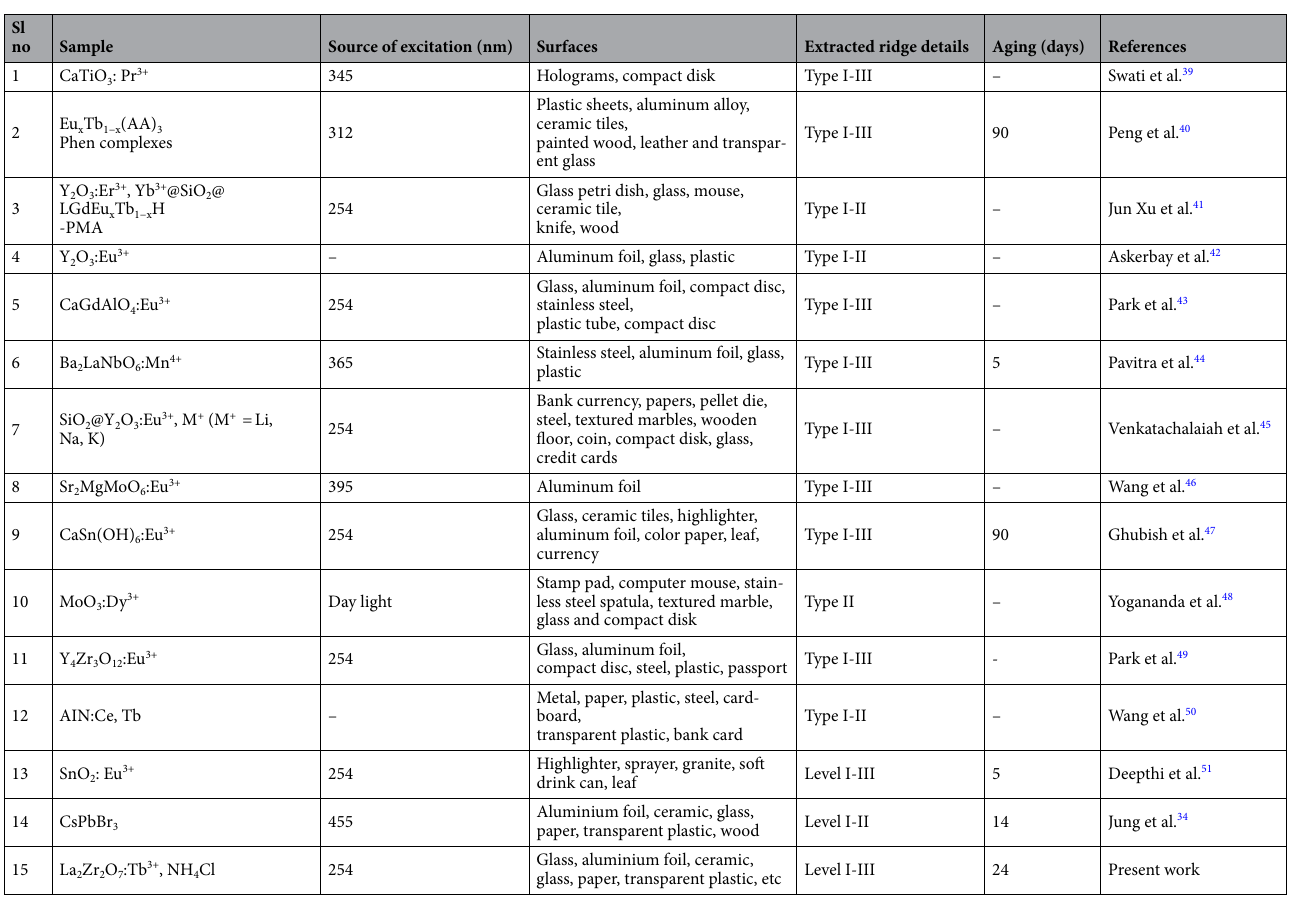
Table 1. Previous literature of various materials used for visualization of LFPs followed by powder dusting